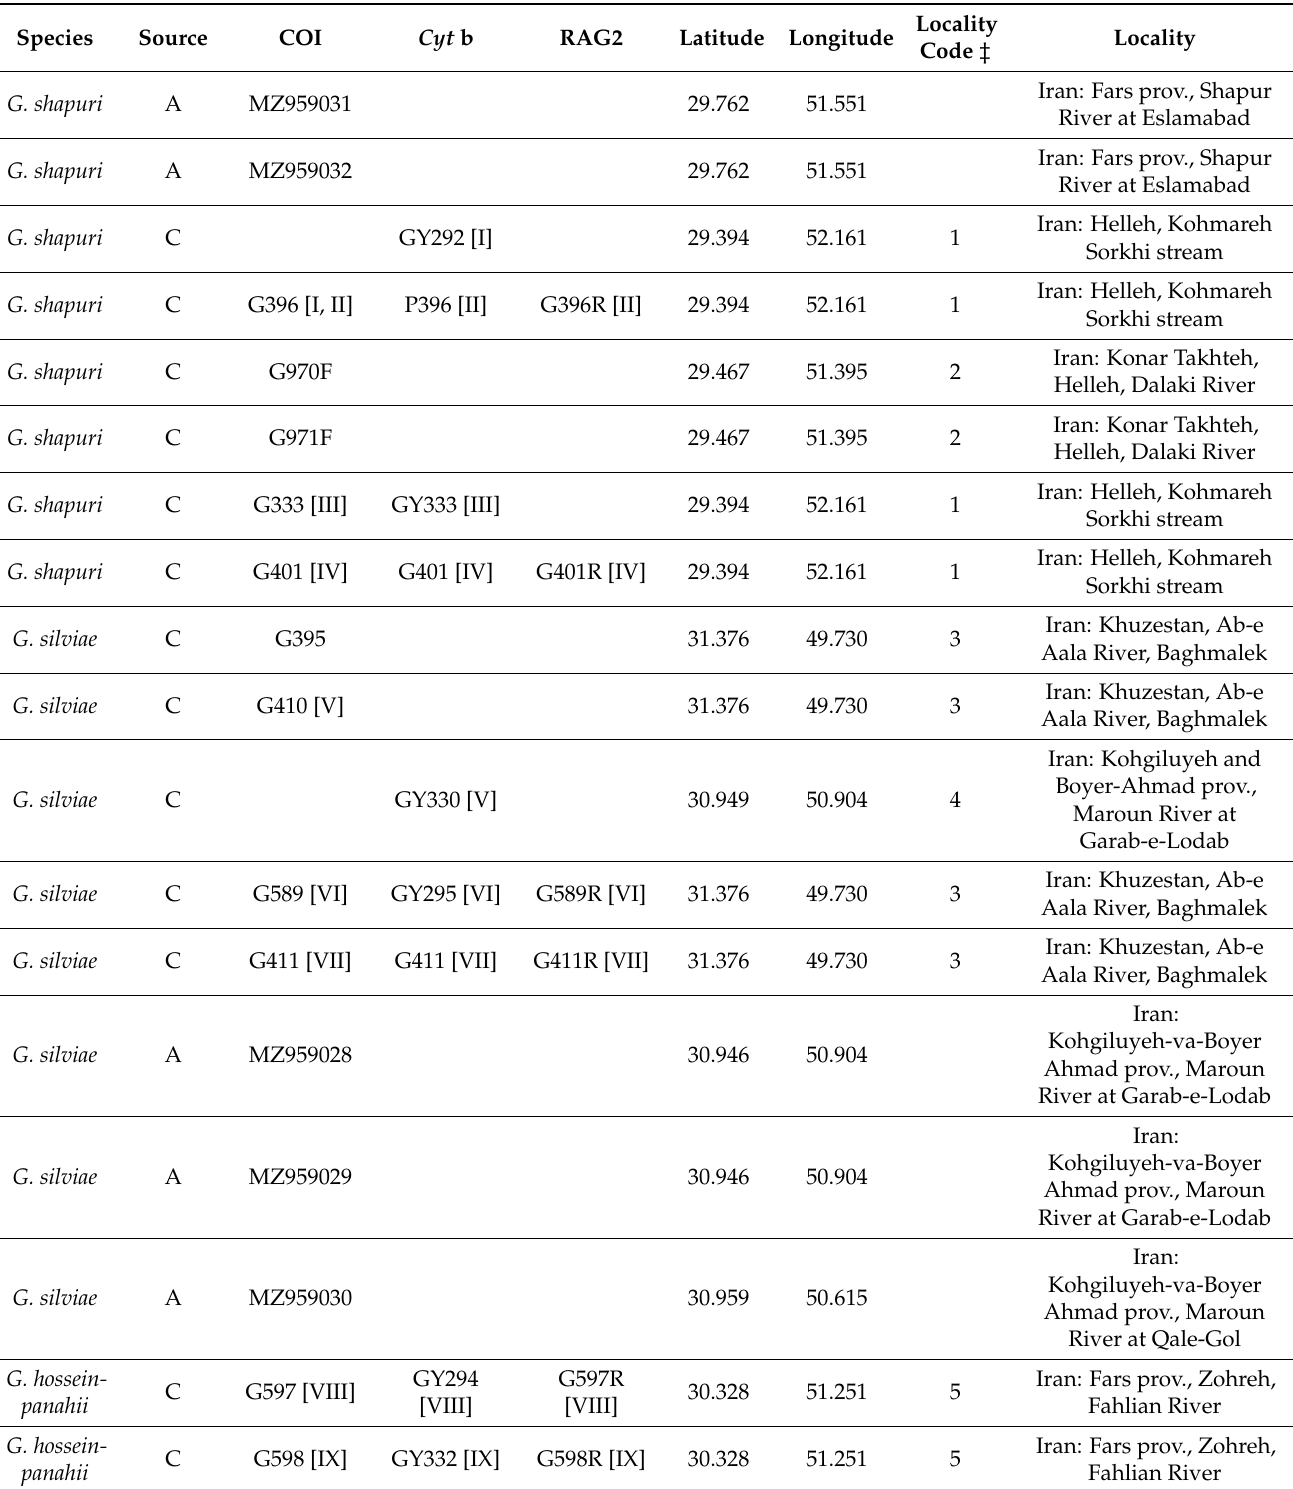
Table 1. List of novel and previously studied Glyptotorax spp. specimens from the Middle East used in this study. Sequences used for the combined analysis (COI + Cyt b + RAG2) are marked with